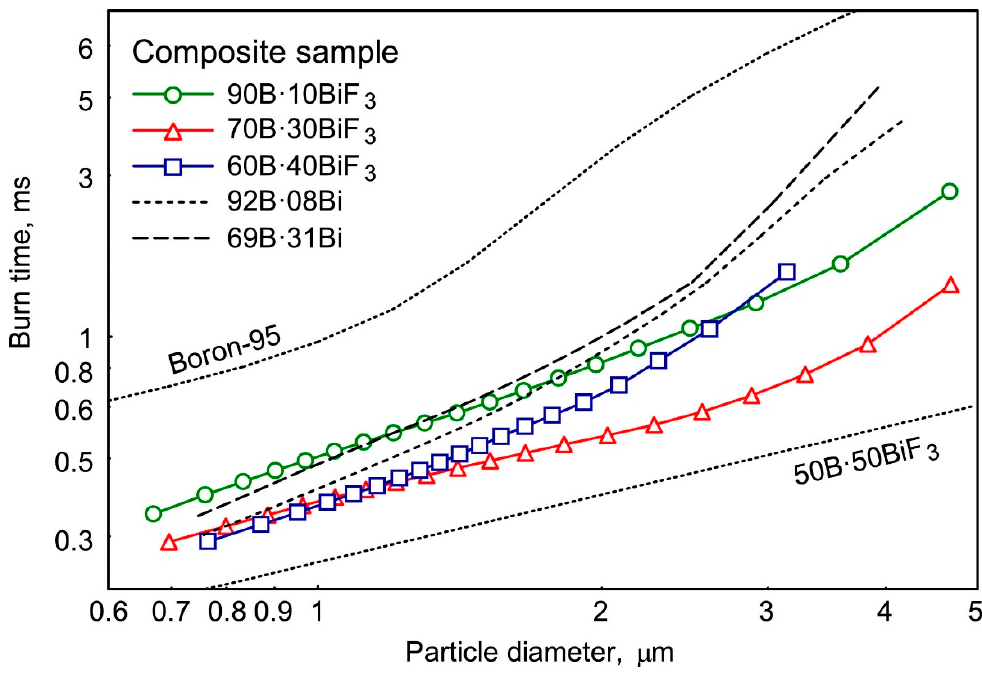
Figure 18. The burning time–particle size correlations for B·BiF 3 and B·Bi composite powders burning in air (Boron- 95 [57], 50B·50BiF 3 [58]). Reproduced from [56], with permission from Elsevier, 2020.